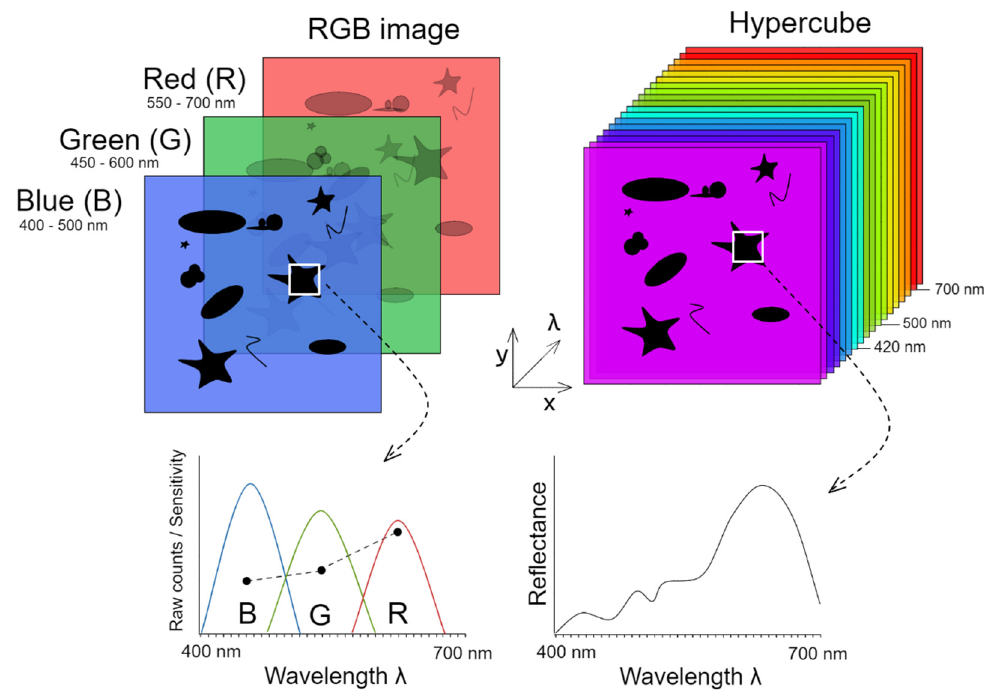
Figure 3. Comparison in the amount of information provided by an RGB image and a hyperspectral image cube from a heterogenous seafloor area.